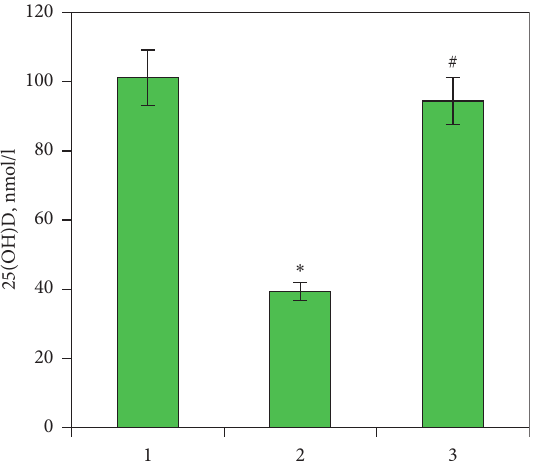
Figure 1: 25-Hydroxyvitamin D level in blood serum after prednisolone and vitamin D evaluated by ELISA in rat serum of three animal groups: (1) control; (2) prednisolone administration; (3) prednisolone and vitamin D 3 administration. All data are presented as mean ± SEM of three independent experiments done in triplicate; ∗ p < 0 . 05 vs. control; # p < 0 . 05 vs. prednisolone